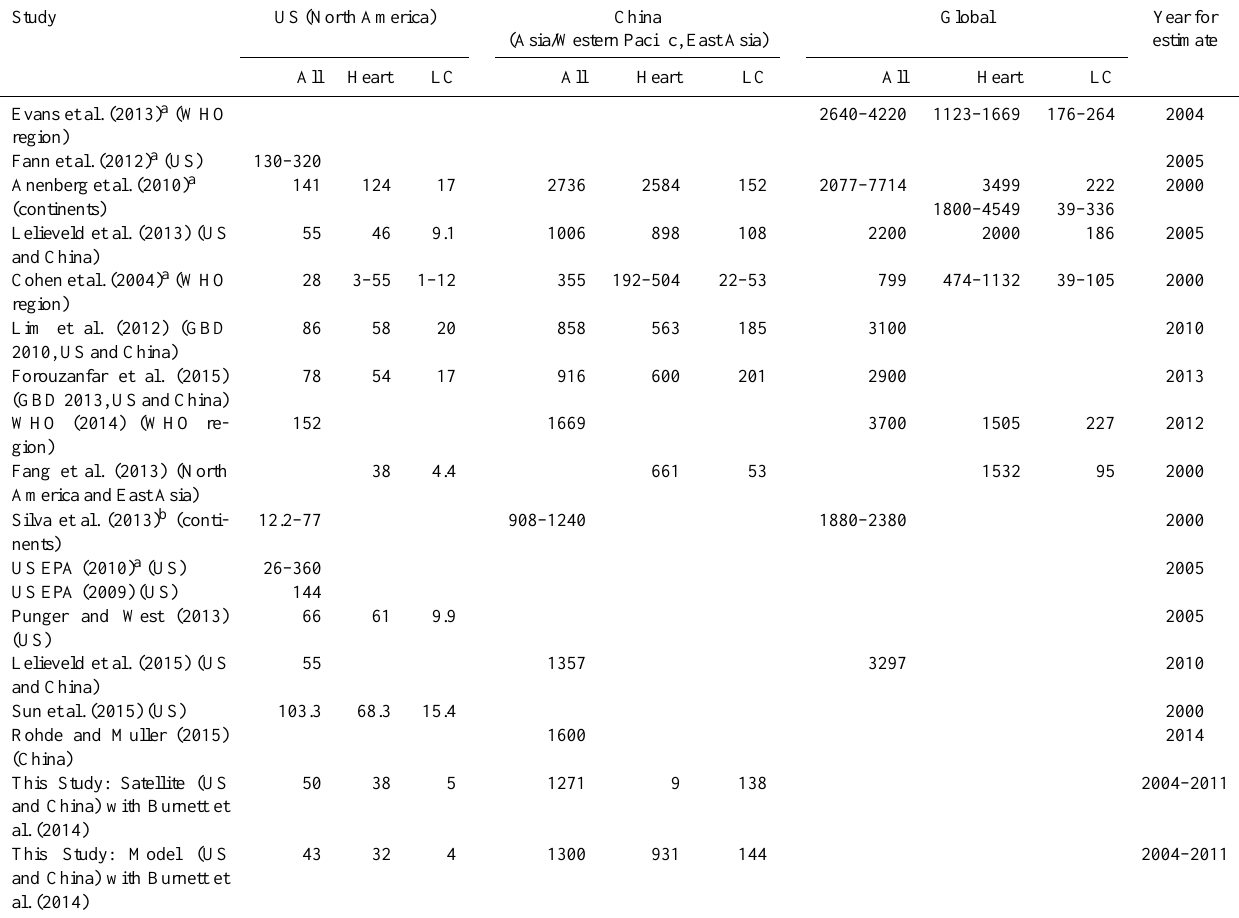
Table 1. Premature mortality from PM 2 . 5 exposure by all-cause (All), heart disease (heart), and lung cancer (LC) as estimated in other studies for the globe, US (or North America), and China (or Asia). Values are for ( × 1000 deaths per year). All cause values for this study are calculated as the sum of heart disease, lung cancer, and respiratory disease deaths (as opposed to calculating this based on an all-cause CRF). a Study provides several estimates determined using different CRFs. b Study provides several estimates from 14 different atmospheric models. Table 3 provides additional information on the data sources and concentrations response functions used in these